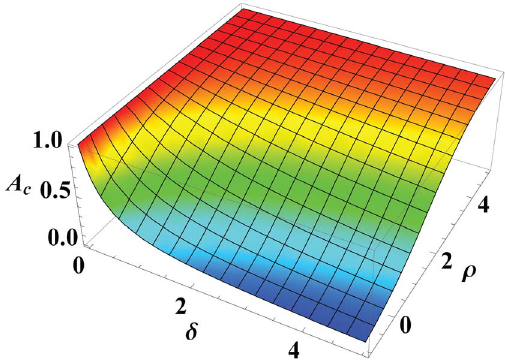
Figure 1. The relationship among A c , s and r . As s and r increase, A c will decrease while the value of A c will sharply increase when s and r are very small (or